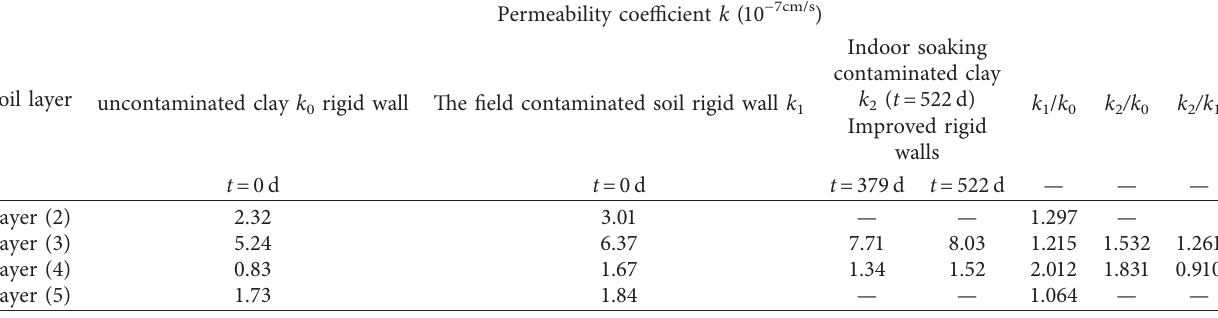
Table 8: Permeability test results of contaminated and uncontaminated soil samples.